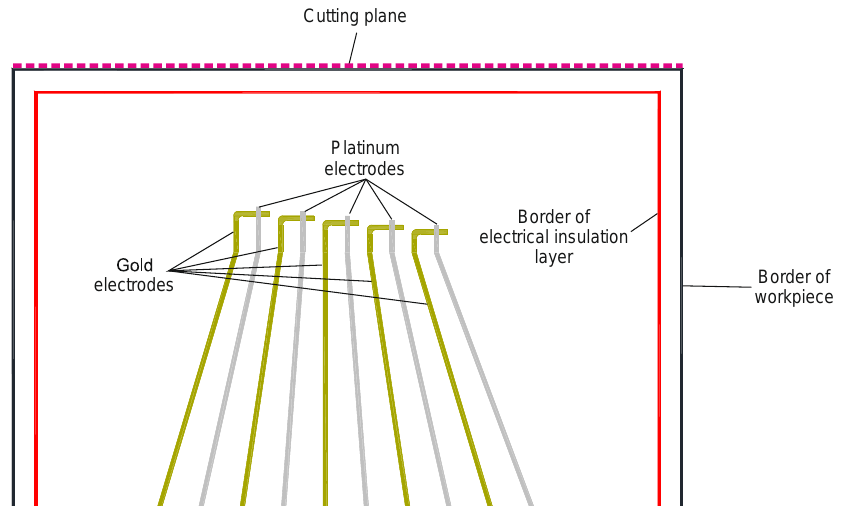
Figure 1. Top view of thermocouples on the workpiece. Five thermocouples are formed from gold and platinum electrodes with varying distance to the cutting plane.